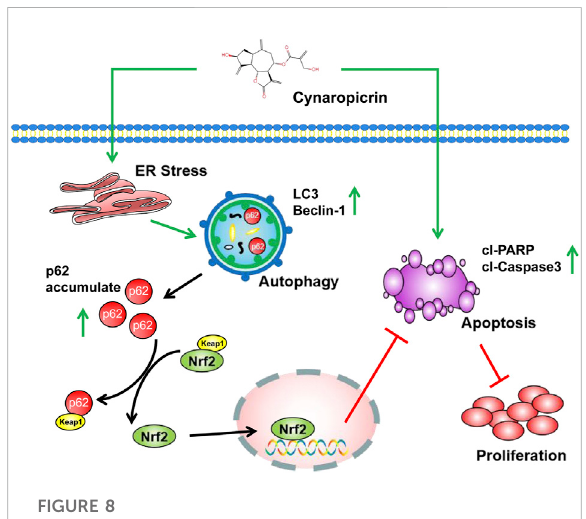
FIGURE 8 Schematic diagram of the anti-NB effects of